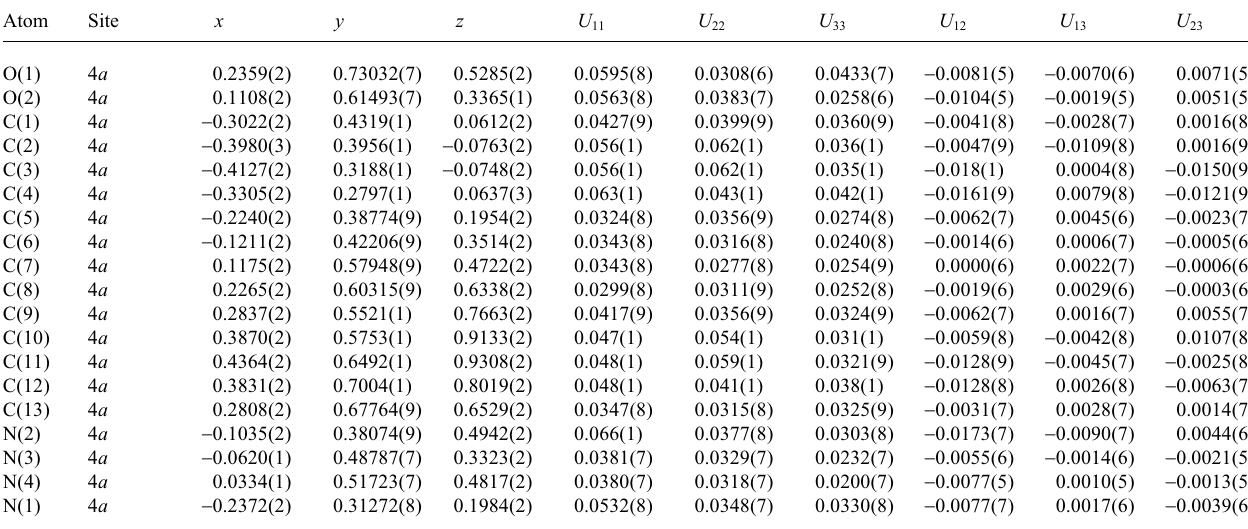
Table 3. Atomic coordinates and displacement parameters (in Å 2 )